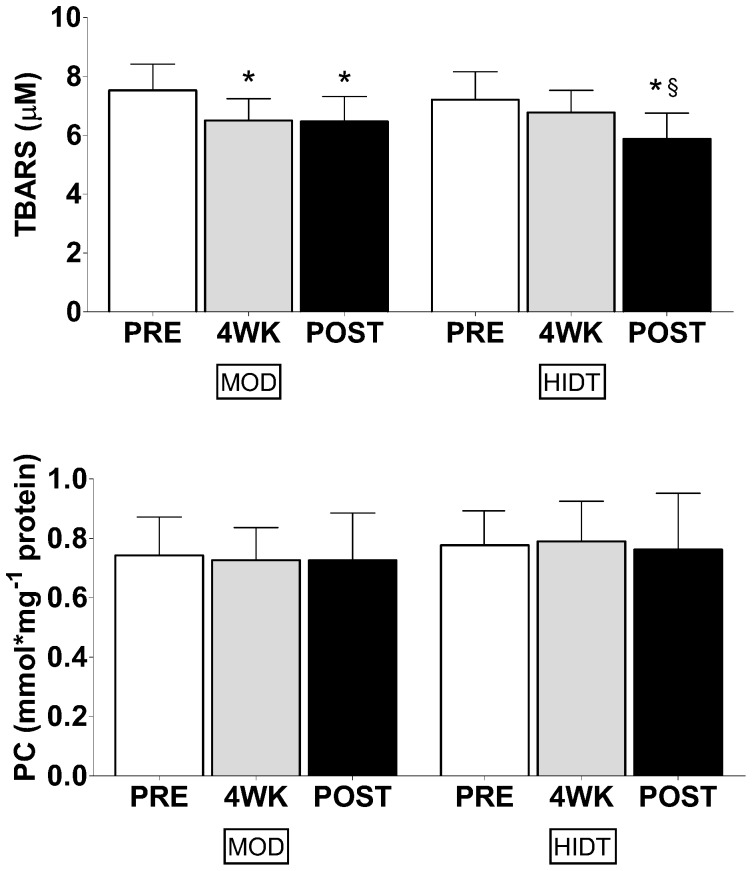
Effect of continuous moderate-intensity training (MOD) and high-intensity discontinuous training (HIDT) on thiobarbituric acid-reactive substances (TBARS) and protein carbonyls (PC).White bars represent pre-training (PRE) values, grey bars 4 weeks (4W) of training values and black bars post-training (POST) values. Values are expressed as means ± SD. * Significantly different from PRE (P<0.05). § Significantly different from 4WK (P<0.05).